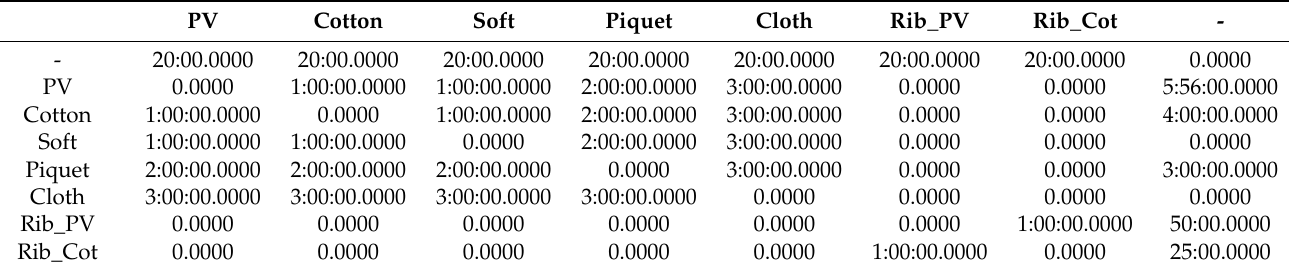
Table 4. Setup time for production (in